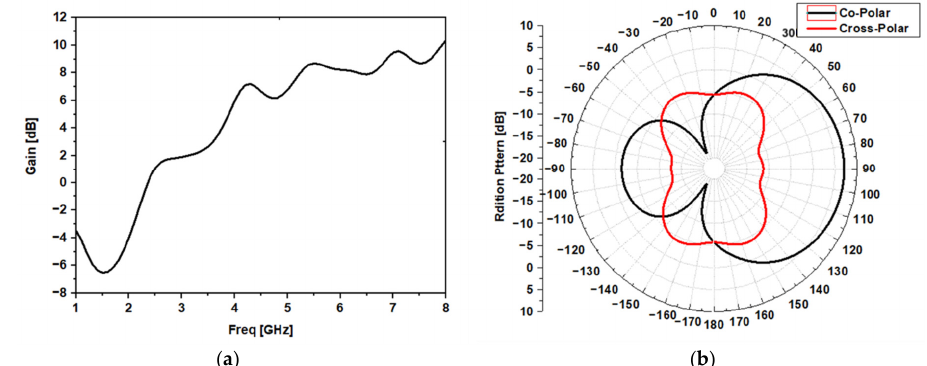
Figure 4. Simulation results of the gain ( a ) versus frequencies ( b ) at 5 GHz.